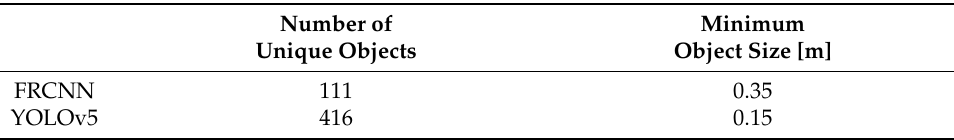
Table 1. Comparison of number of detected objects and minimum detectable object size between FRCNN and